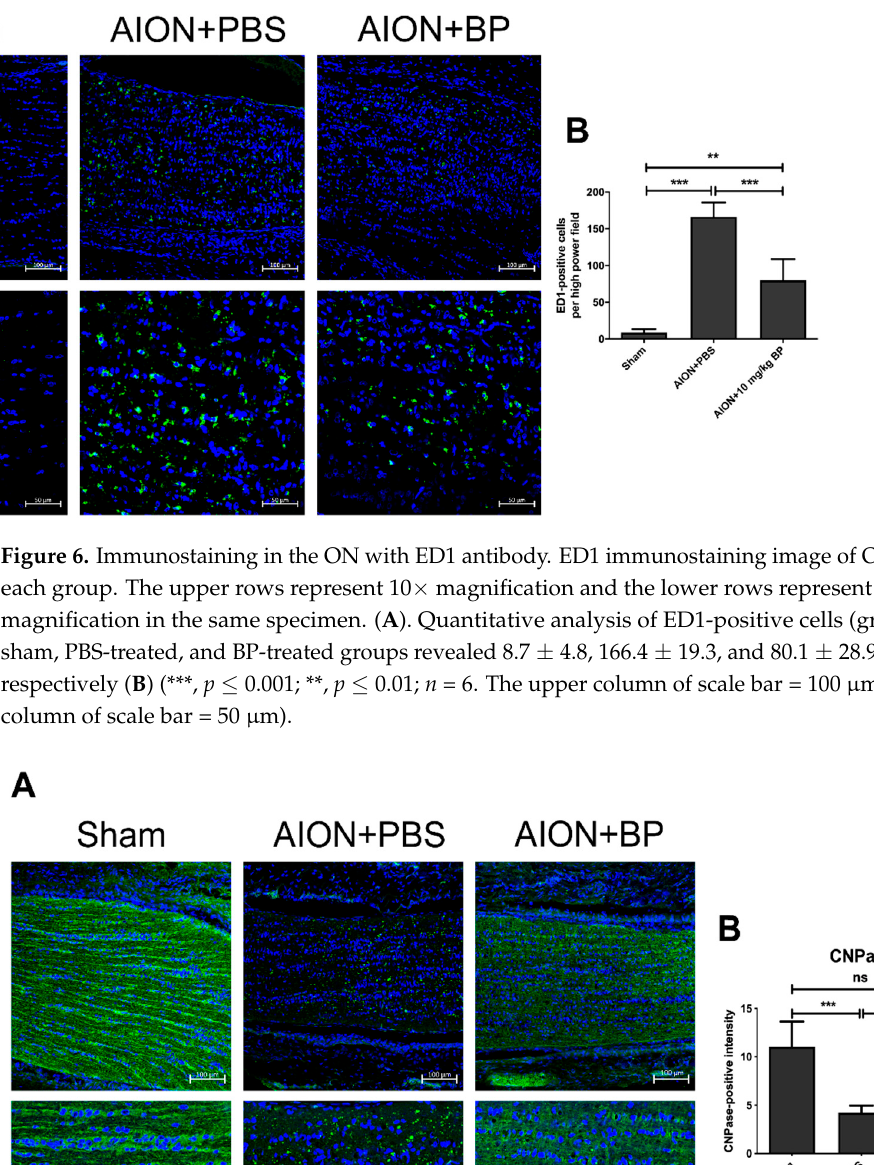
Figure 6. Immunostaining in the ON with ED1 antibody. ED1 immunostaining image of ON tissue in each group. The upper rows represent 10× magnification and the lower rows represent high (20×) magnification in the same specimen. ( A ). Quantitative analysis of ED1-positive cells (green) in the sham, PBS-treated, and BP-treated groups revealed 8.7 ± 4.8, 166.4 ± 19.3, and 80.1 ± 28.9 cells/HPF, respectively ( B ). (***, p ≤ 0.001; **, p ≤ 0.01; n = 6. The upper column of scale bar = 100 μ m, the lower column of scale bar = 50 μ m.)